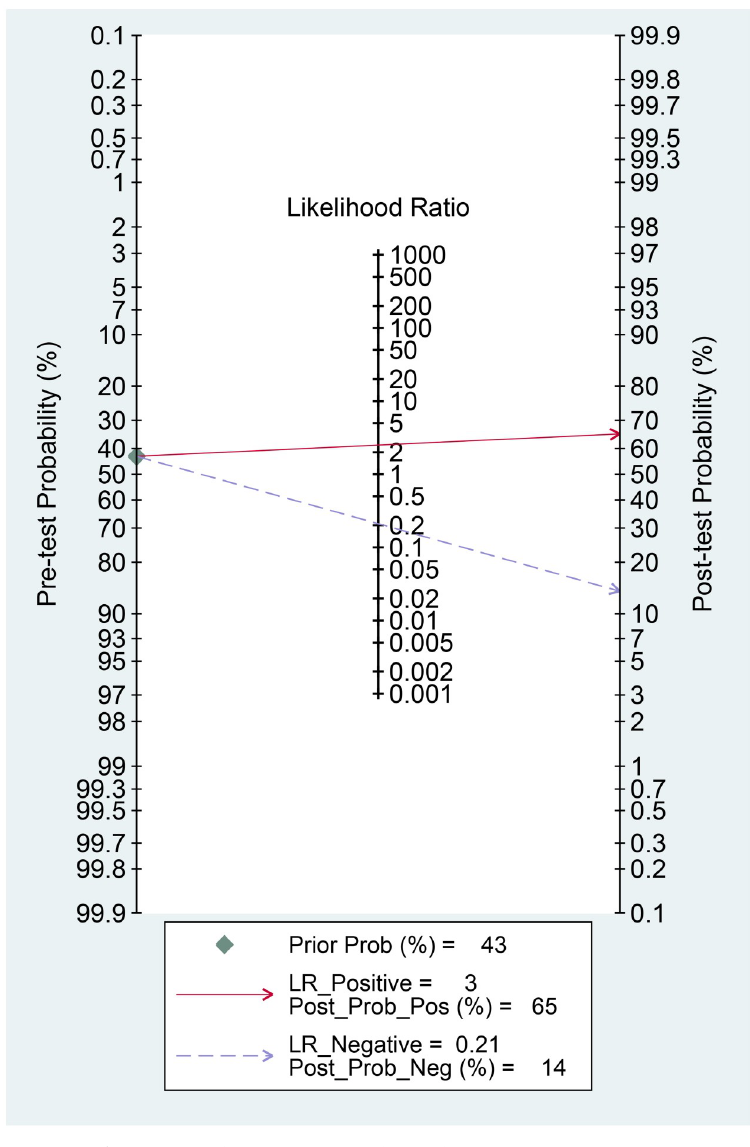
Fig 4. Fagan’s nomogram for FIB-4 > 1.45 and